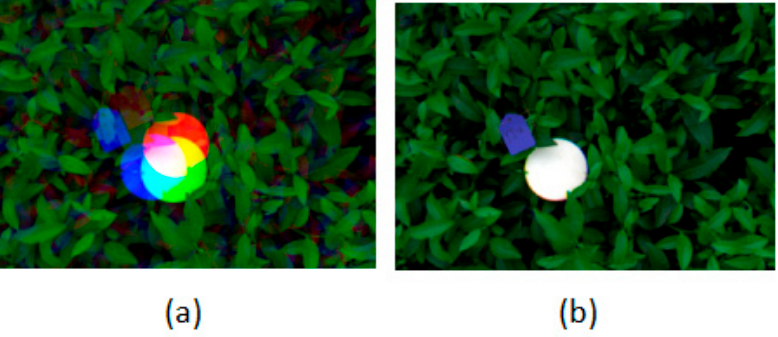
Figure 4. RGB three-channel combined true color image ( a ) before and ( b ) after registration.